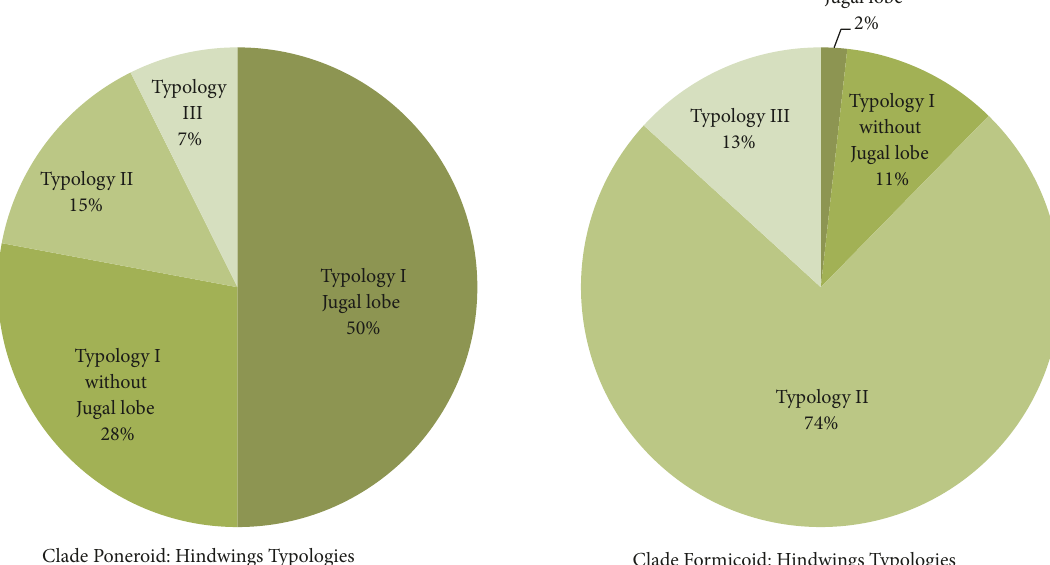
Figure 7: Percentages related to the genera for each Typology, respectively, in the Clade Poneroid and